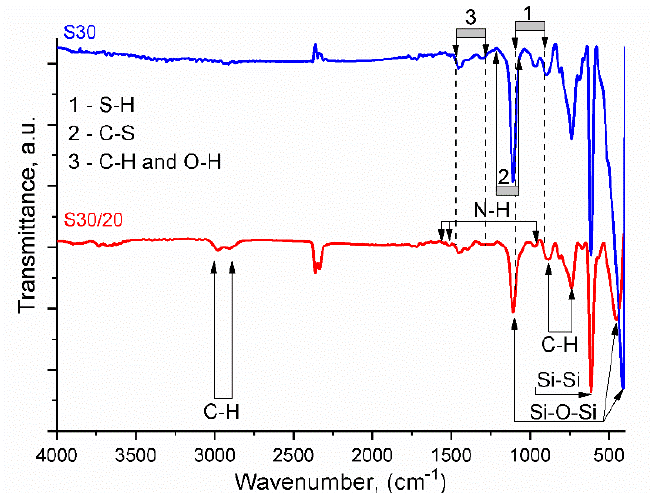
Figure 6. FTIR data for S30 with a single AuNP layer with inclusion of minor number of self-aggregated nanoparticles in comparison S30/20 ) .